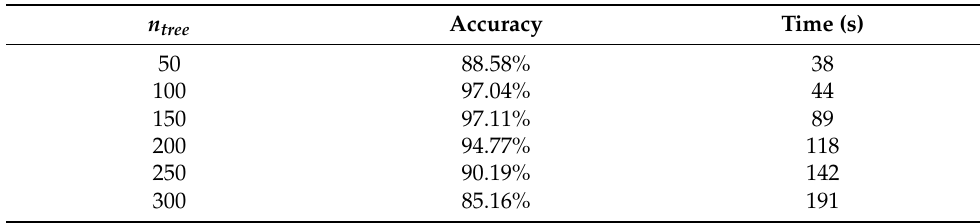
Table 2. Parameter Optimization ( n tree ). n tree